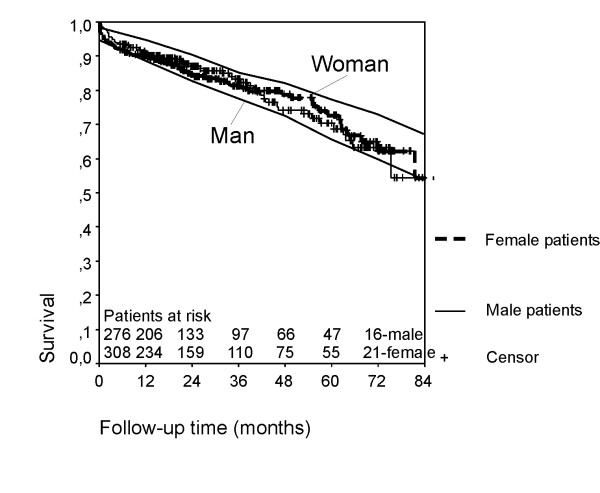
Survivor functions for patients after AVR compared to the age- and gender matched German population. The actuarial survival rate at 6 years was 61.4 ± 3.8 % and comparable to the estimated survival function for 75 year-old male and female Germans.